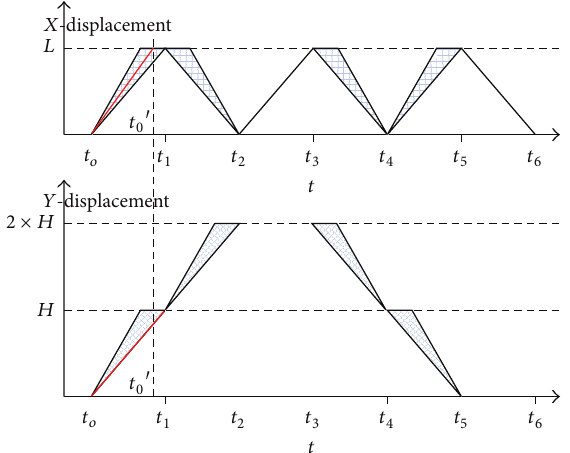
Figure 1: The fault self-recovered movement.